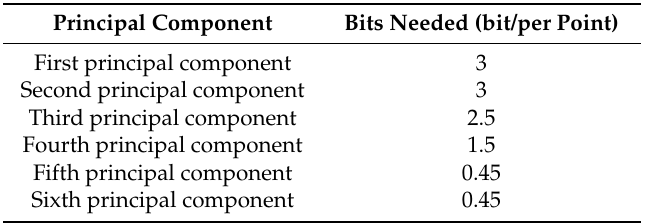
Table 2. Quantization bit for reduced-dimensional matrix.